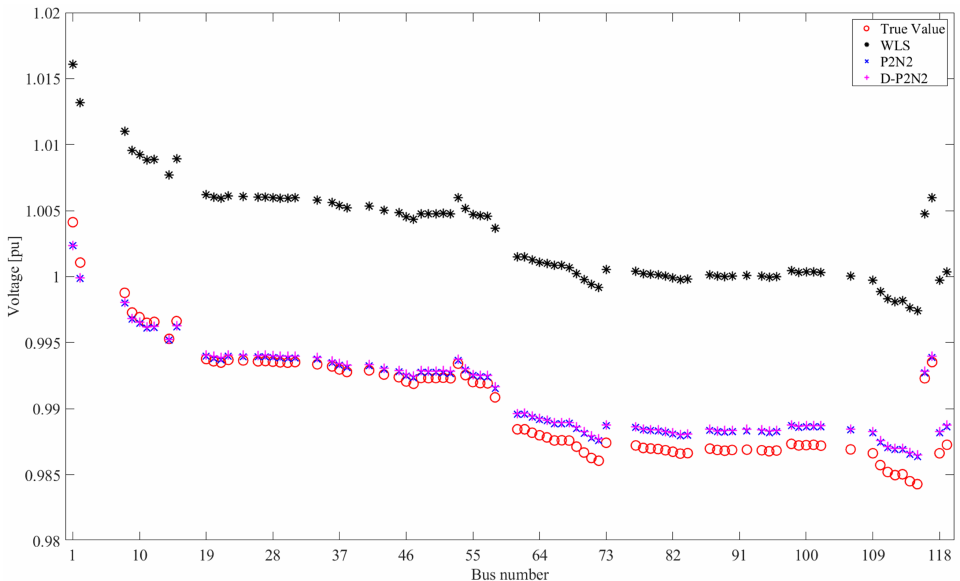
Figure 10. Estimated voltage magnitude at Phase A in Scenario 2. The third scenario is carried out with a limited number of measurements; 14 load power measurements are neglected (compared with the first scenario). In this case, the network is unobservable because of the limited number of measurements. Thus, the WLS cannot obtain estimates for the voltage magnitudes; however, Figure 11 shows the effectiveness of the P2N2- and D-P2N2-based neural network even with the unobservable distribution